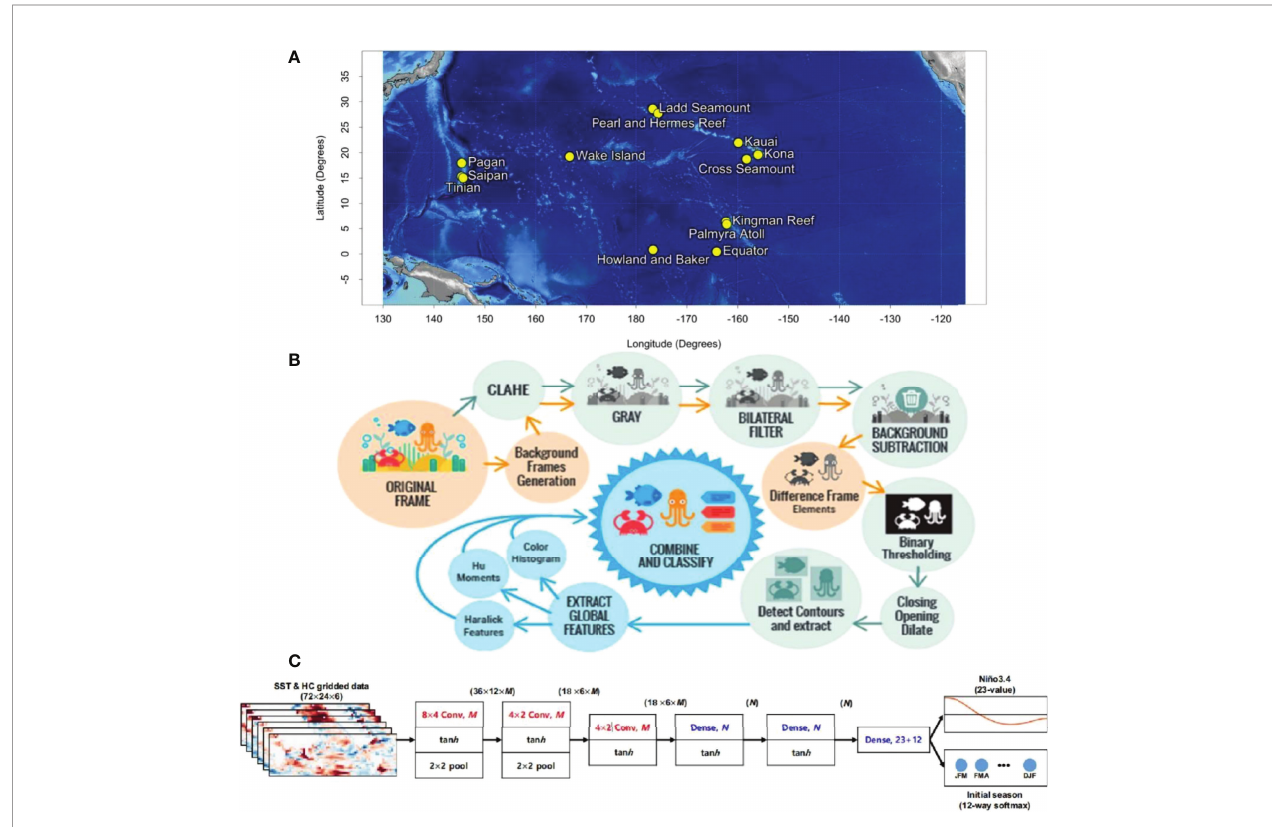
FIGURE 1 | (A) Map of the 13 acoustic recording locations. (Allen et al., 2021). (B) Image processing pipeline (Lopez-Vazquez et al., 2022). (C) Architecture of the All-season CNN (A_CNN) model for ENSO forecasts (Ham et al.,